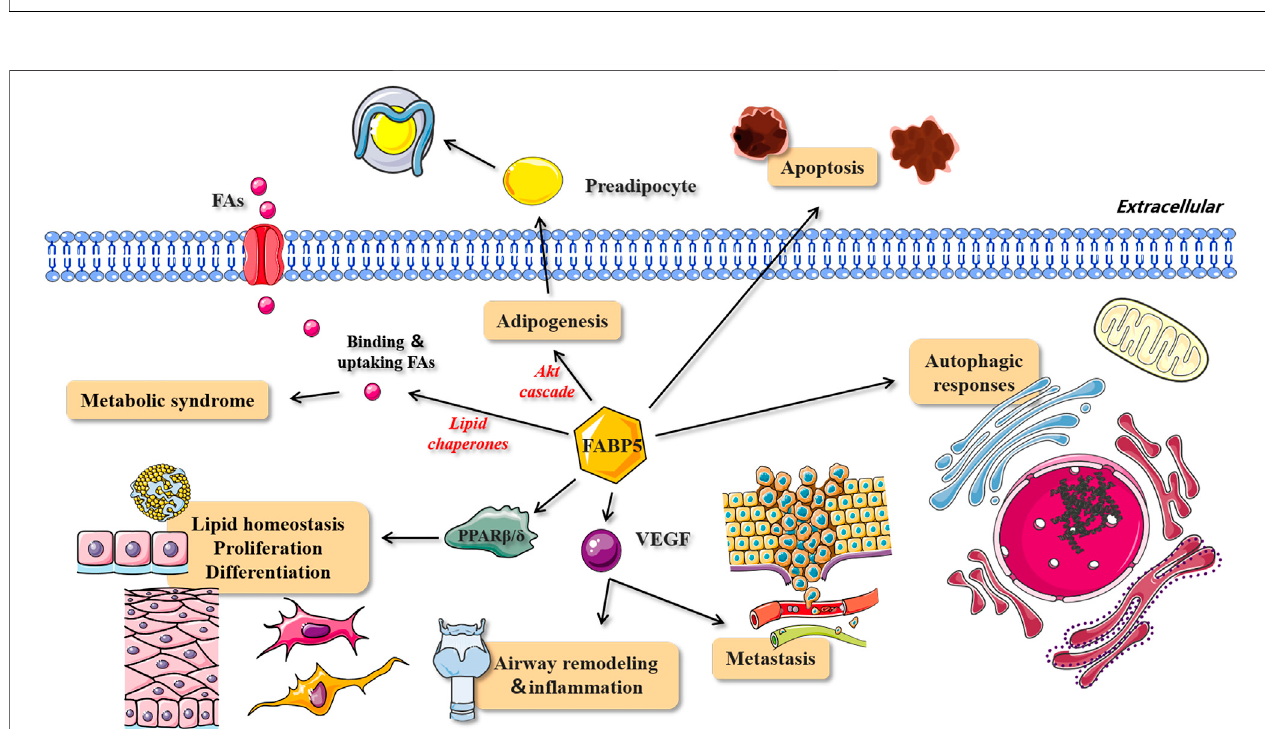
FIGURE5| TheroleandmechanismofFABP5inlipidmetabolism,homeostasis,cellproliferationanddifferentiation.Therolesandcorrespondingsignalpathways of FABP5 in metabolic syndrome, adipogenesis, lipid homeostasis, proliferation, differentiation, metastasis, airway remodeling and in fl ammation, apoptosis and autophagic responses. FAs, fatty acids; VEGF, vascular endothelial growth factor.